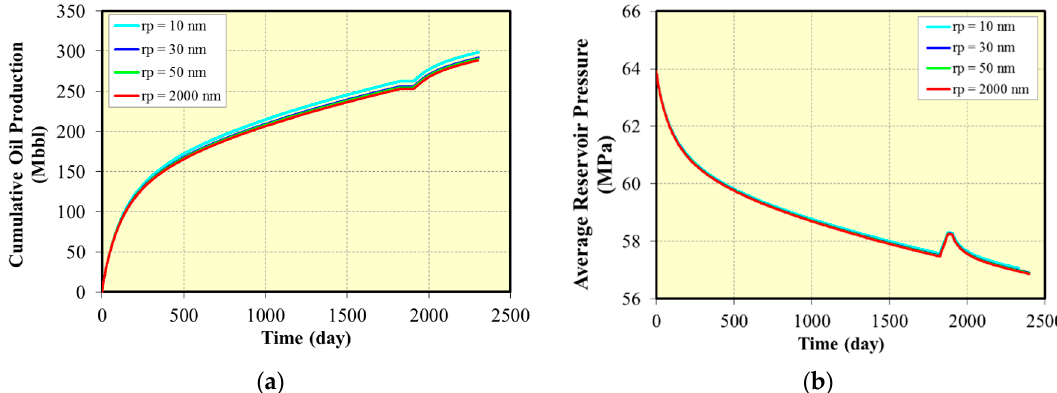
Figure 8. Effect of different pore radius of shale matrix with one huff-n-puff cycle on oil production and reservoir pressure: ( a ) Cumulative oil production for different pore radius of shale matrix; ( b ) Average reservoir pressure for different pore radius of shale matrix. Table 10. Summary of results for huff-n-puff with different matrix permeability.